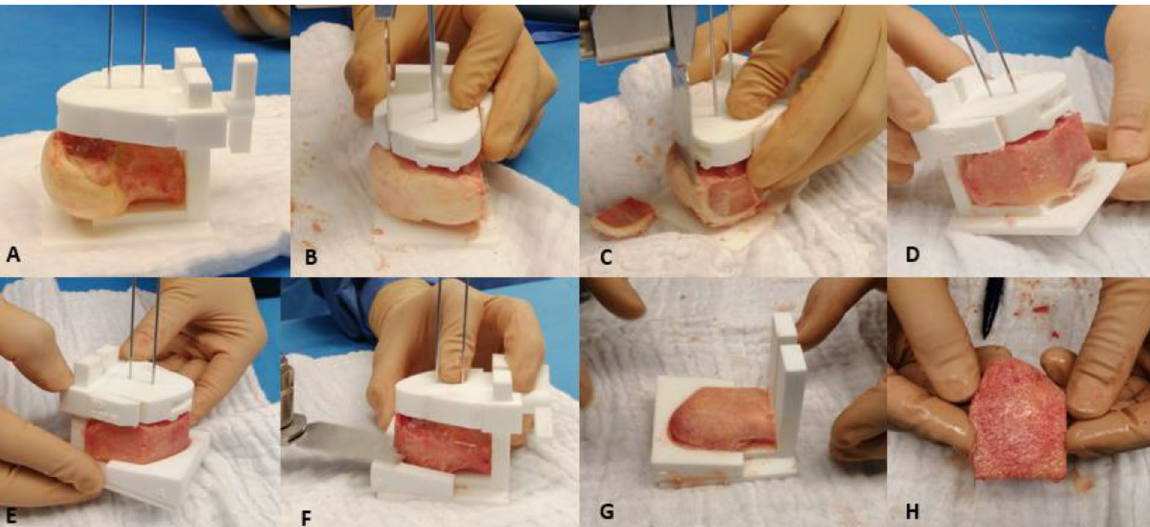
Fig. 3 Intraoperative preparation of structural impacted bone allograft with the customized 3D printed kit. ( A ) The femoral head is placed on the platform and fixed with two 1.8 mm Kirschner pins through the cutting block, without full engagement to the bottom. ( B ) The anterior and posterior borders of the graft are cut perpendicular to the platform. ( C ) The medial contour of the graft is trimmed, which identically matches the curvature of the medial cortex of the patient. Correct graft positioning can hereby later controlled. ( D ) The desired result after graft shape contouring with an oscillating saw. ( E ) Next, the designated cast is pushed to the graft, again matching the prepared medial curvature of the graft. ( F ) The upper surface of the cast is used as guiding plane to obtain ( G ) the desired bone wedge. ( H ) Finally, the intended structural bone allograft can safely be removed from the guide and is ready for introduction in the osteotomy gap